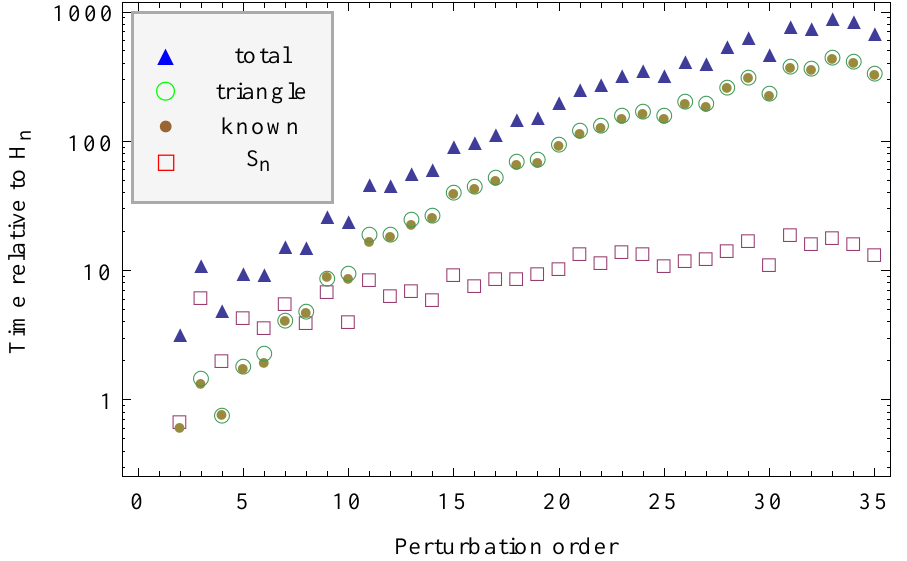
Fig. 2 Ratios S n , “known”, “triangle”, and “total” (in logarithmic scale) of the times spent at each perturbation order of the Lie transforms algorithm to the time spent in the computation of the new Hamiltonian term t = H n using Eq.